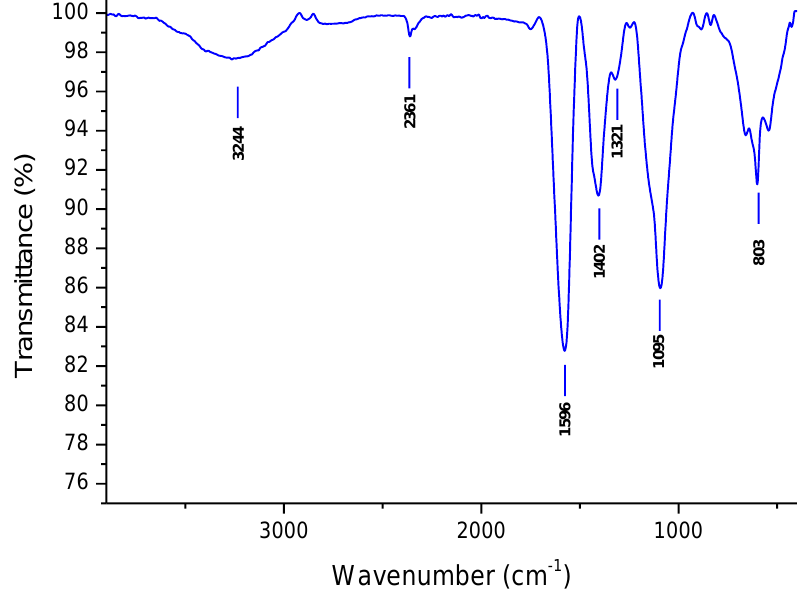
7 of 19 Table 1. Global composition of CFPS fraction extracted from Clematis flammula . Extraction Yield (%, w / w )